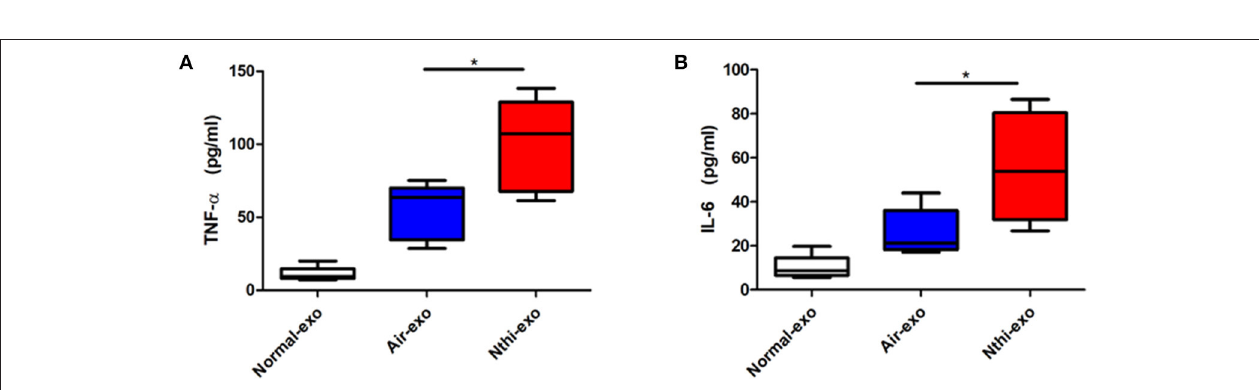
FIGURE 3 | Characterization of exosomes from the BALF of mice exposed to NTHi lysate or air. (A) Transmission electron microscopy images of NTHi-Exos and air-Exos. (B) Western blotting analysis of exosomal markers CD63, CD9, Hsp70, Tsg101, and negative biomarkers Calnexin. (C) Nanoparticle tracking analysis determined the size distribution of NTHi-Exos and air-Exos. Results are presented as means ± SEM of three independent experiments.